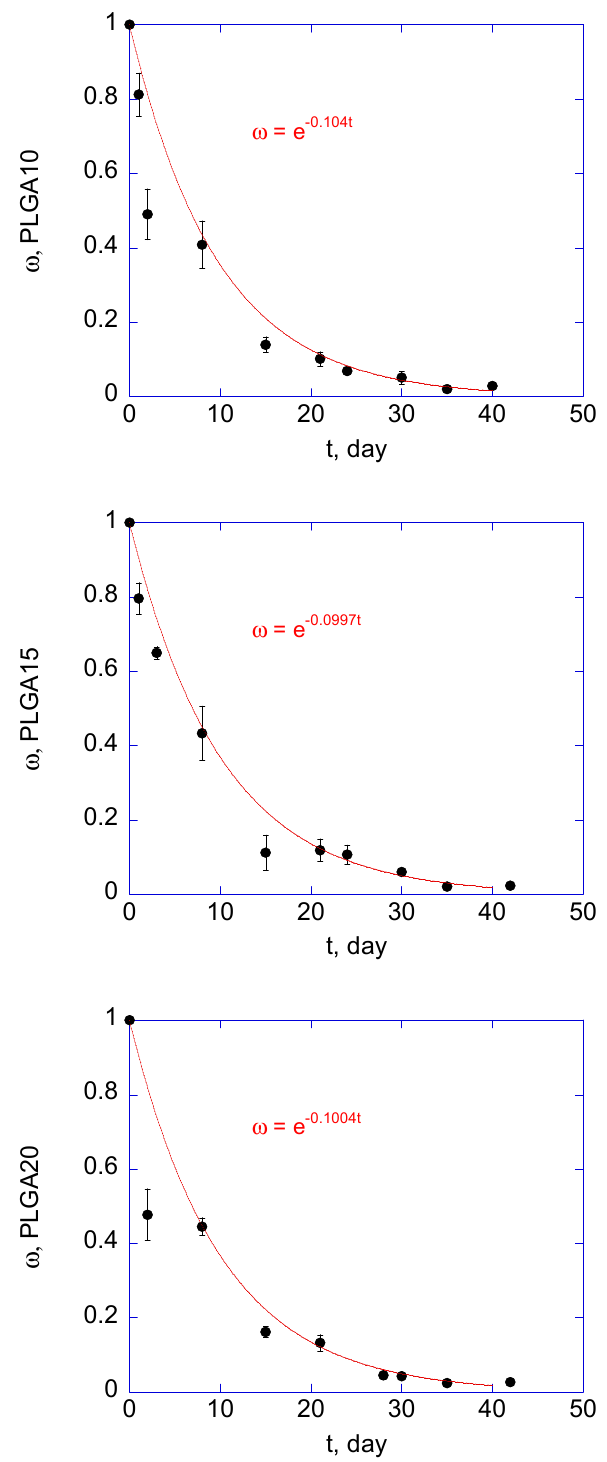
Figure 5. Time trend of non-dimensional molecular weight of PLGA10, PLGA15, and PLGA20 MS after suspension in phosphate buffer saline solution (PBS) (pH = 7.4). Experimental data were fit to Equation (19) (solid lines: fitting results).